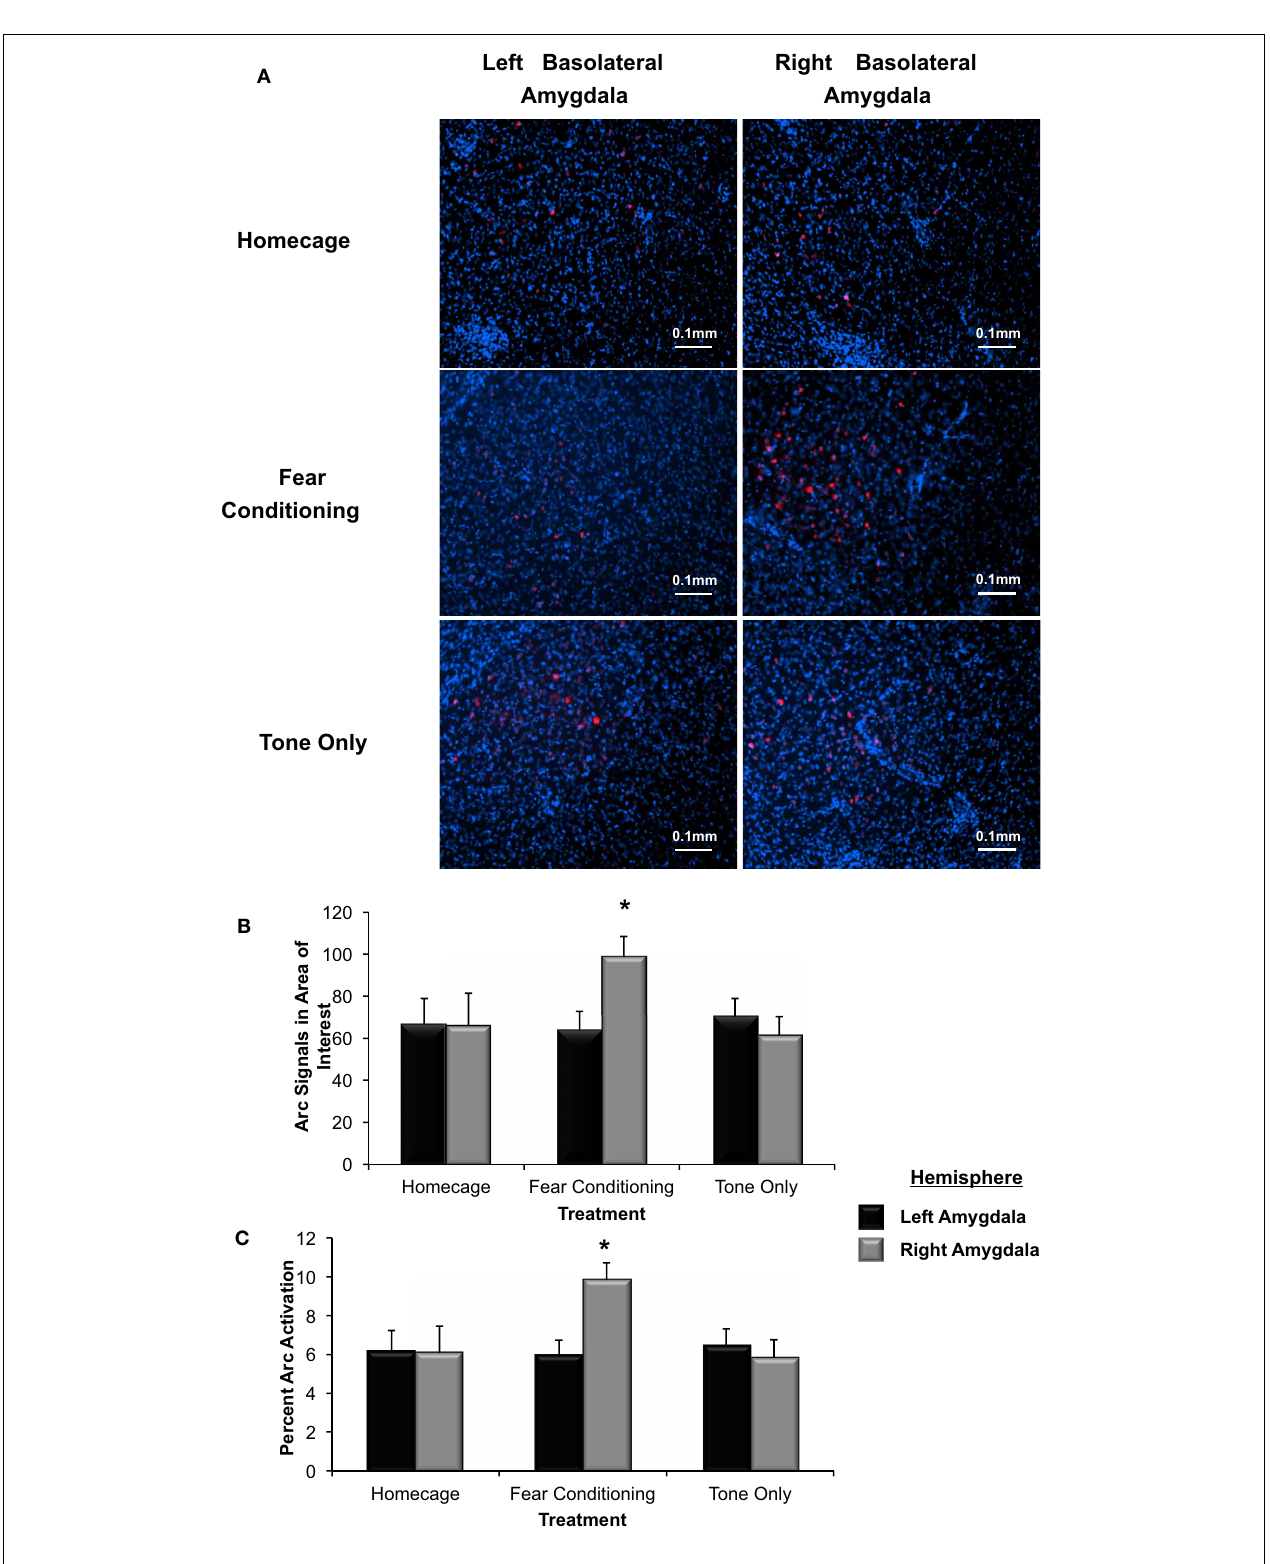
FIGURE 5 | (A) Immunohistochemical analysis of the effect of fear conditioning on Arc expression in the right and left basolateral amygdala. Fear conditioning elevates Arc immunoreactivity in the right, but not left basolateral amygdala. (B) Mean ( + SE) number of Arc signals measured in the